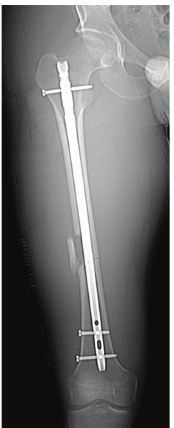
Figure 1: Preoperative images of the right diaphyseal Winquist and Hansen type II femur fracture. Note the lateral butterfly fragment, and the relatively transverse fracture through the medial cortex.